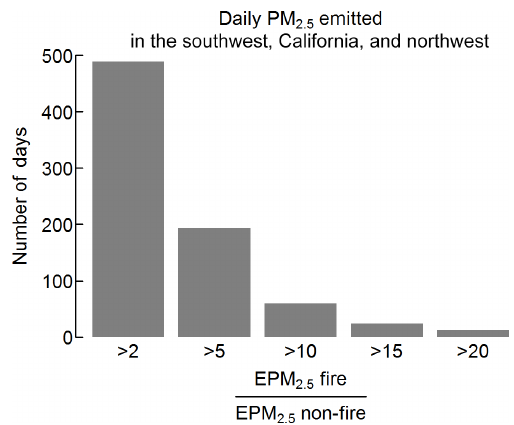
Figure 19. Number of days over 2003–2015 when the wildfire-to- non-wildfire PM 2 . 5 emission ratio in the west exceeds thresholds of 2, 5, 10, 15, and 20.